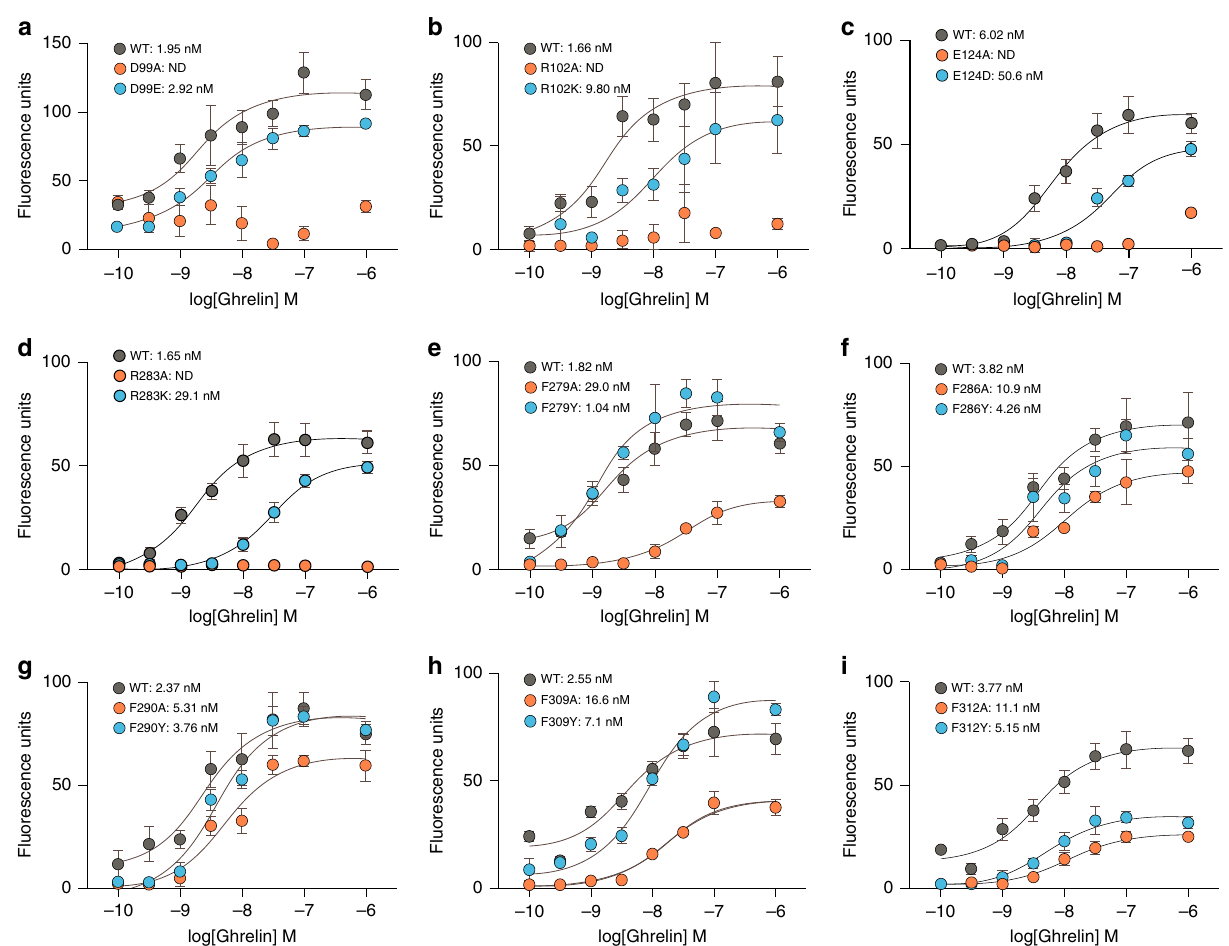
Fig. 4 Mutagenesis analyses. Mutagenesis analyses of the polar amino acids of ligand-binding pocket ( a – d ) and the fi ve phenylalanines forming the crevasse ( e – i ). Receptor activities were examined by intracellular Ca 2 + concentration assay. EC50 values are means ± s.e.m. ( n =